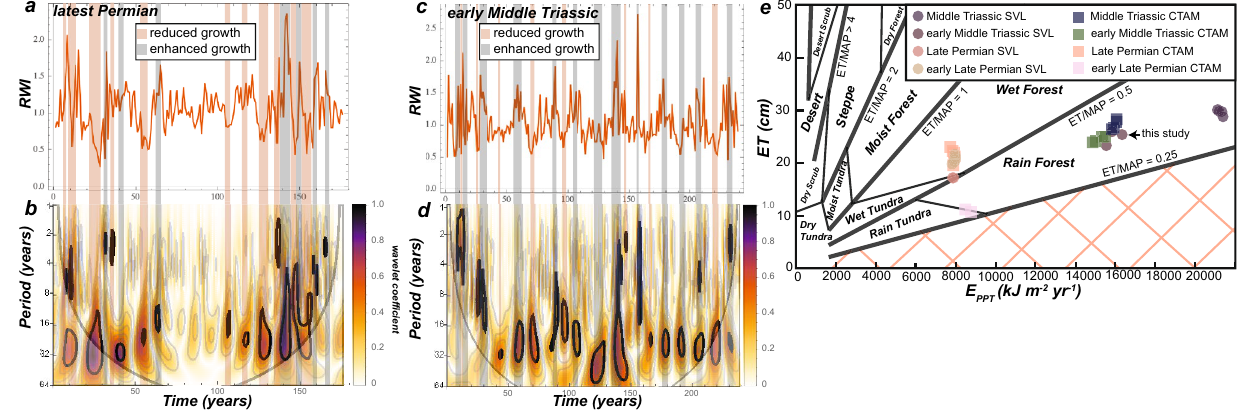
Figure 5. Tree growth patterns and paleoclimate. ( a , b ) RWI and CWT analysis with the derivative of a gaussian (DOG, 2nd derivative) wavelet for the Late Permian Collinson Ridge chronology. ( c , d ) RWI and CWT analysis via the DOG wavelet for the Triassic Allan Hills chronology. Intervals of reduced/enhanced growth as determined by RWI that correlate with significant wavelet coefficients are illustrated by the shaded vertical bars. ( e ) Paleoclimate model results from paleosol geochemistry at each area in the study region from the Permian– Triassic, ET = evapotranspiration, Eppt = energy from precipitation, where these parameters are calculated from the equations for paleosol-based paleoclimate proxies 31,32 . Humidity provinces and floral regimes fall between each of the lines, and the calculated ET and Eppt values from each paleosol are shown by the symbols. Figure created using Adobe Illustrator, v. 25.0.1,